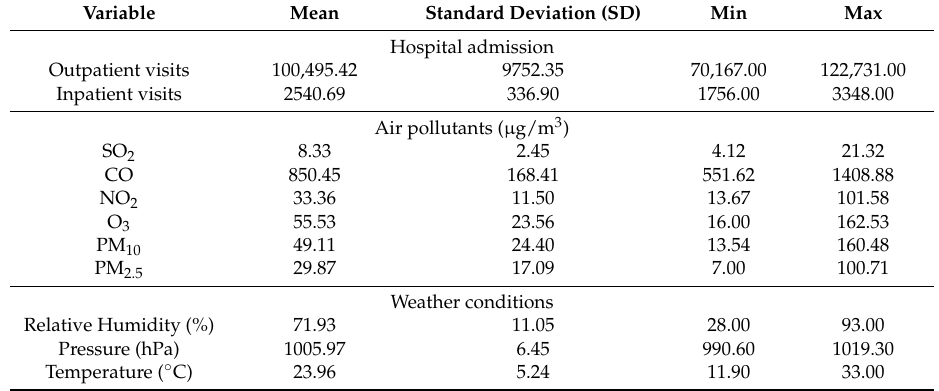
Table 1. Summary statistics of outpatient/inpatient visits, air pollution and weather conditions ( n =